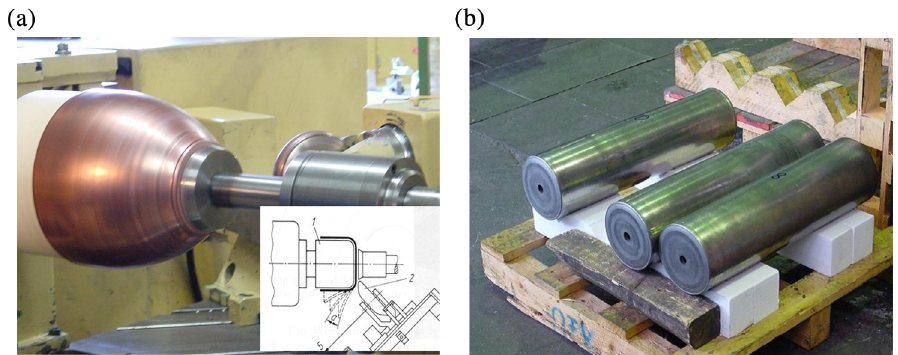
FIG. 24. (a) Spinning process. (b) Spun Nb